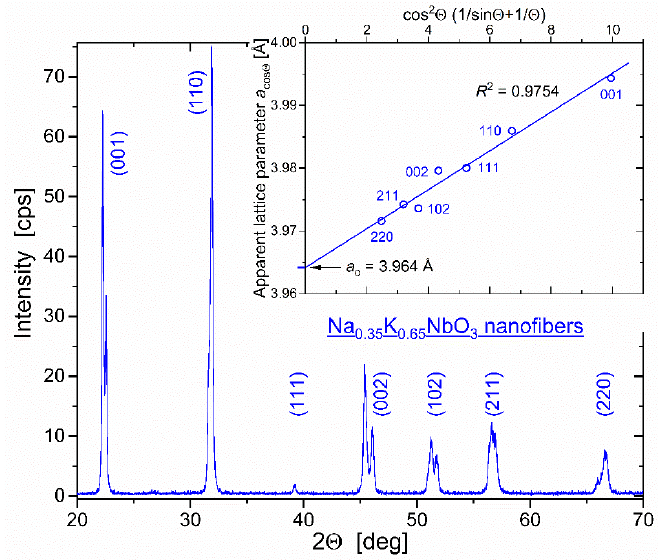
Figure 3. XRD patterns of NKN nanofibers recorded using a Siemens D-5000 powder diffractometer in Cu K α 1 radiation ( λ = 1.5406 Å). Bragg reflections are notified by Miller indices for pseudo-cubic crystal unit cell Na 0.35 K 0.65 NbO 3 . Inset shows extrapolation of all the “apparent” parameters a cosΘ to the “true” lattice parameter a o = 3.96 4 Å using the Nelson– Riley Equation (1). Five main XRD peaks were enlarged and deconvoluted by Lorentzian lines in Figure 4. They accord to the positions and the total number of all the Bragg manifolds character- istic for the monoclinic crystal system in Na 0.35 K 0.65 NbO 3 (ICSD-38004) [37].